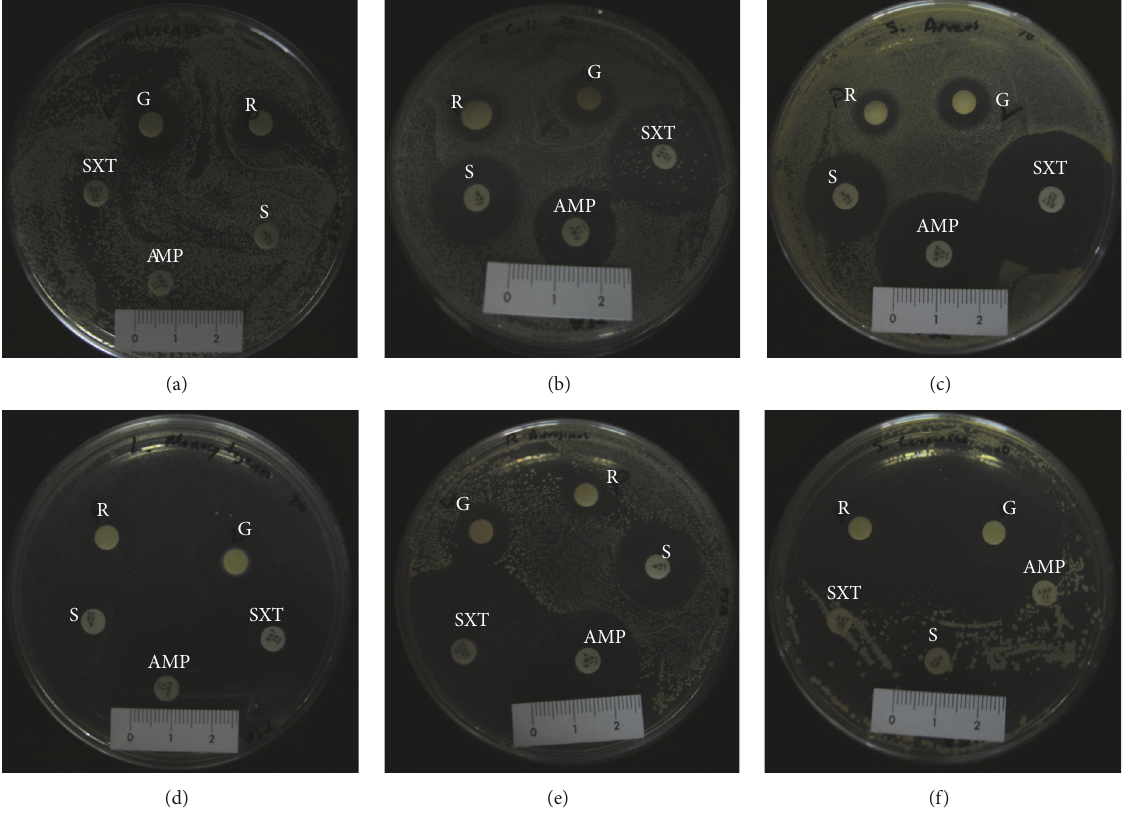
Figure 3: Antimicrobial activity of oil extracted from green cactus pear (G); oil extracted from red cactus pear seeds (R); streptomycin (S); ampicillin (AMP); and sulfamethoxazole/trimethoprim (SXT). Candida. albicans (ATCC 10231) (a); Escherichia. coli O58:H21 (ATCC 10536) (b); Staphylococcus aureus (ATCC 13565) (c); Listeria monocytogenes (CCUG15526) (d); Pseudomonas aeruginosa (ATCC15442) (e); Saccharomyces cerevisiae (CECT1942)